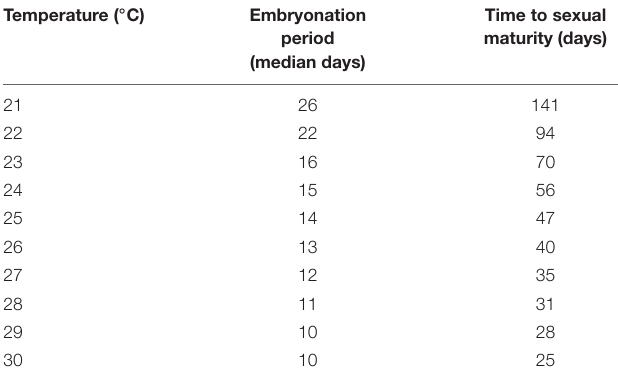
TABLE 2 | Predicted time of embryonation from hatching probability curves using experimental embryonation data (Kaplan–Meier survival estimates), and time to sexual maturity (linear mixed effects model) in